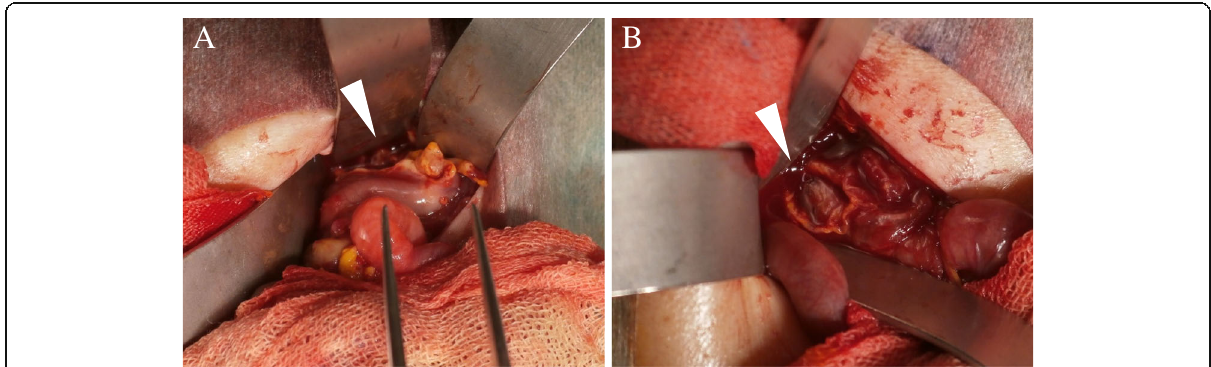
Fig. 2 Operation for gastric and duodenal perforations. a Gastric perforation of 3 cm at the angulus of the lesser curvature (arrowhead). b Duodenal perforation of 1.5 cm at the anterior wall of the duodenal bulb (arrowhead)